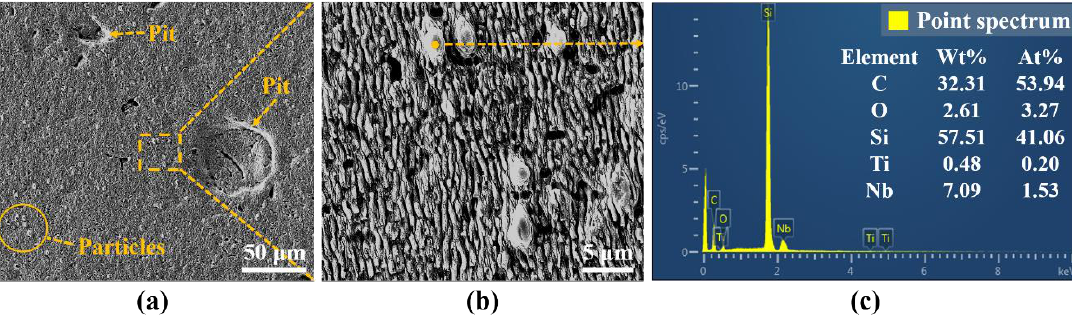
Figure 10. ( a ) The SEM image of polished surface corresponding to pulse energy of 45 µ J, ( b ) the partial enlarged details of the inset ( a , c ) the EDS elemental analysis of microparticles.